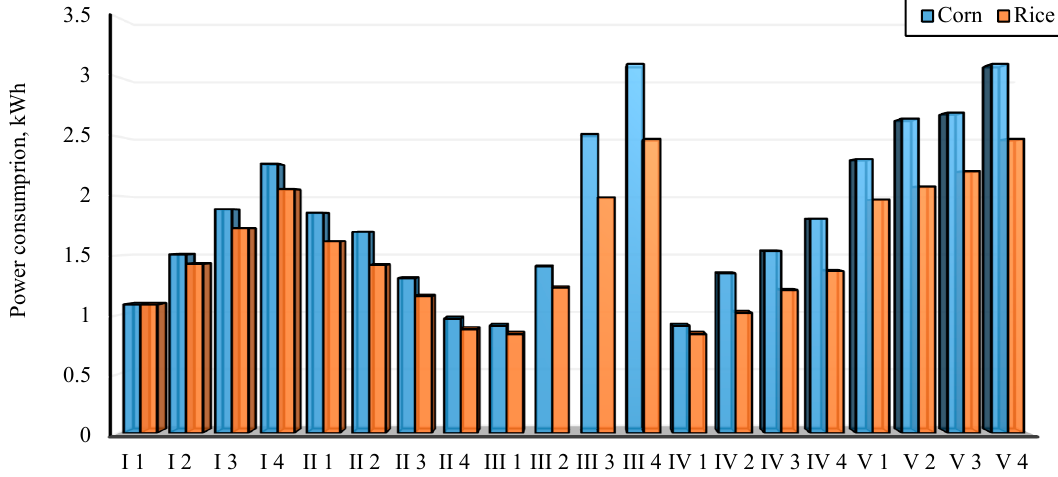
Figure 3. Total power input of a five-disc grinder for the analyzed angular speed settings of working discs.